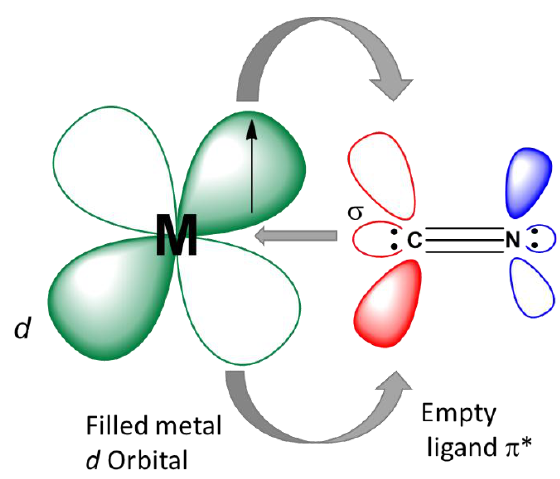
Figure 3. Representation of π back-bonding responsible for the transfer of negative charge from the binder block to an orbital π.